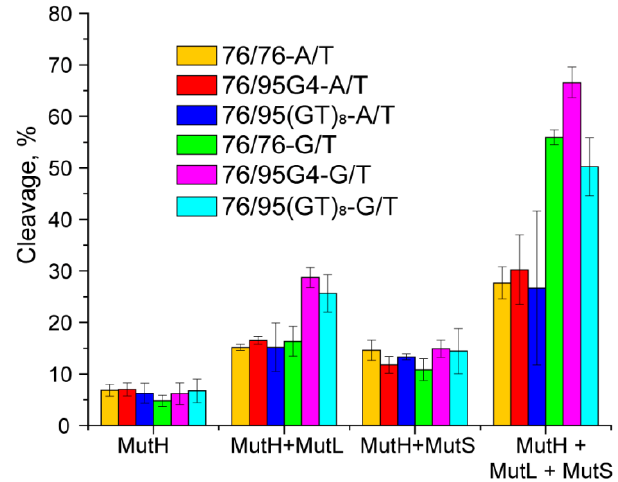
Figure 10. Efficiency of DNA hydrolysis induced by E. coli MMR proteins ( p < 0.05). Data were obtained for endonuclease MutH alone (at a concentration of 250 nM) and for the combinations of MutH with 250 nM MutS or 250 nM MutL as well as with both 250 nM ecMutS and 250 nM ecMutL (all protein concentrations are calculated per monomer). The reaction mixtures were incubated at 37 °C for 1 h.